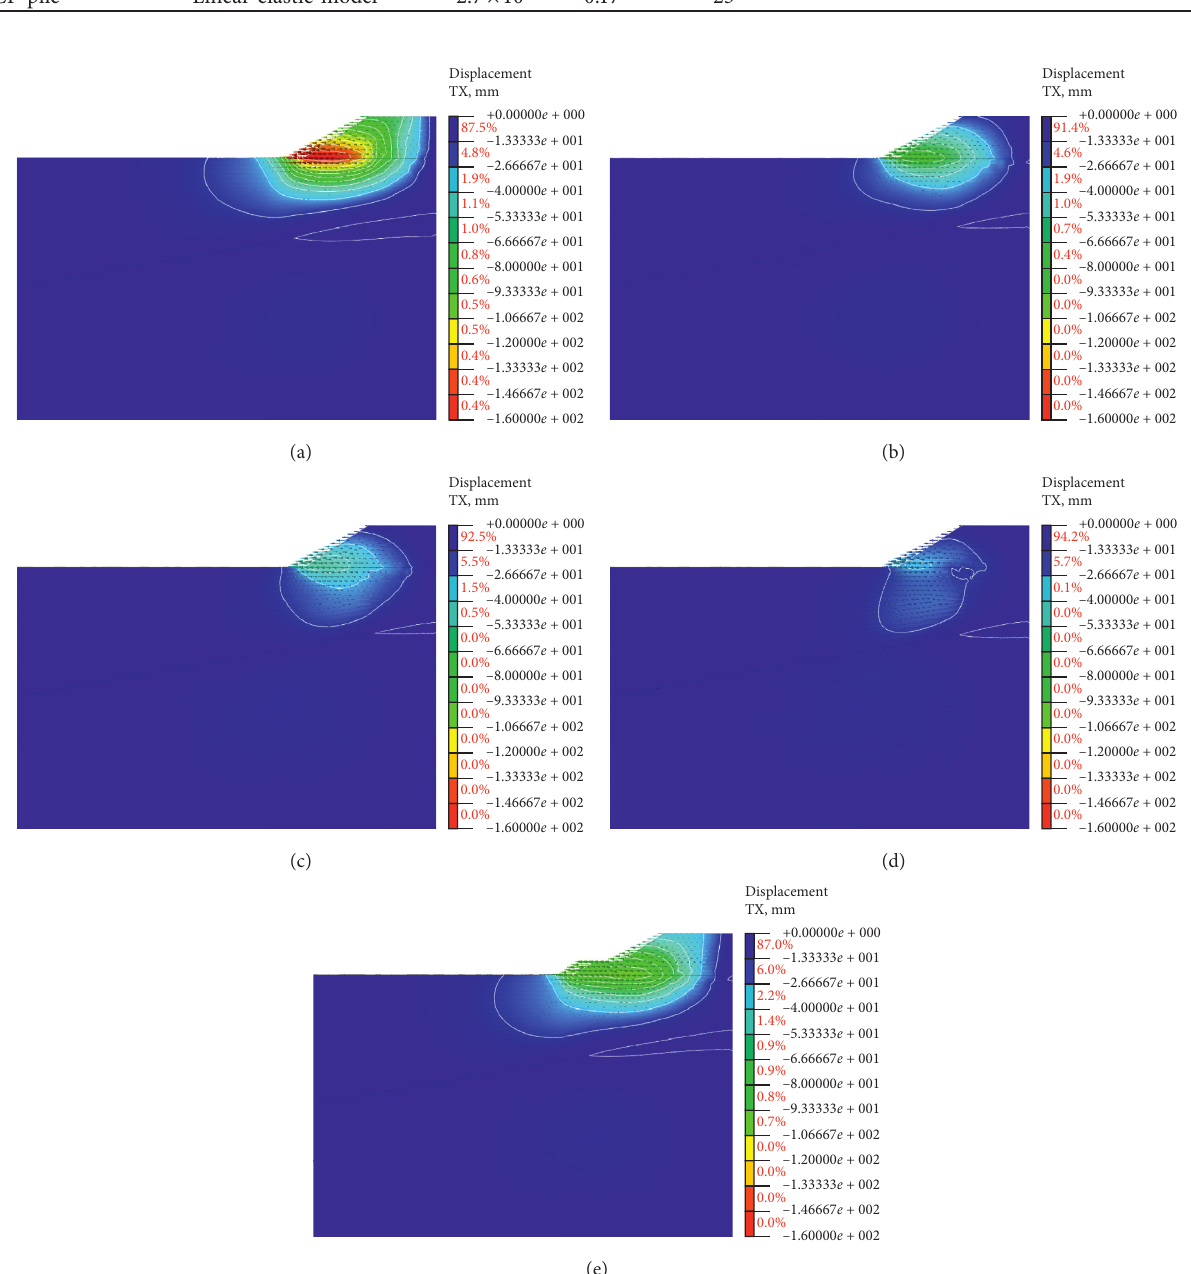
Figure 9: Horizontal deformation of the foundation. (a) Program A, (b) Program B, (c) Program C, (d) Program D, and (e) Program E.